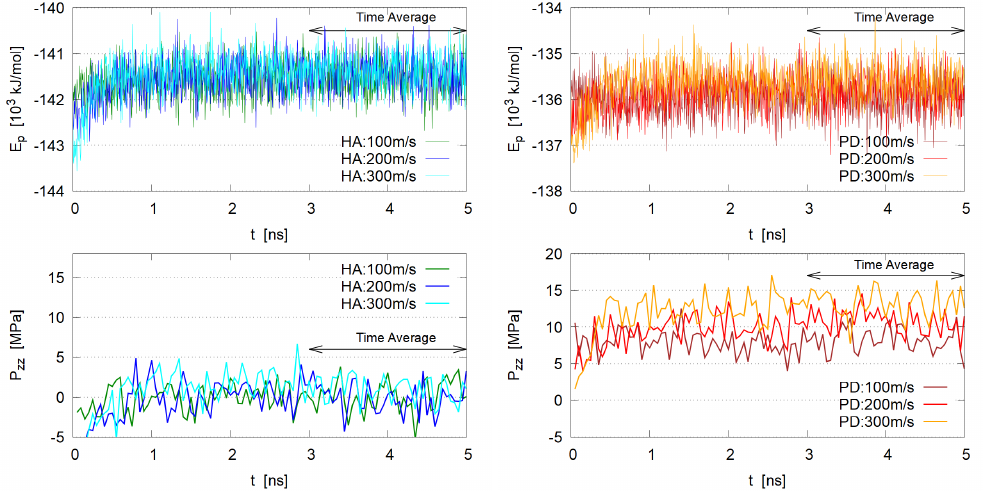
Figure 4. Time evolution of potential energy E p and pressure component P zz normal to the shear direction. ( Left ) HA system, ( Right ) PD system. Since the instantaneous pressure components include large fluctuations, time averaged values in short period (50ps) are plotted for P zz